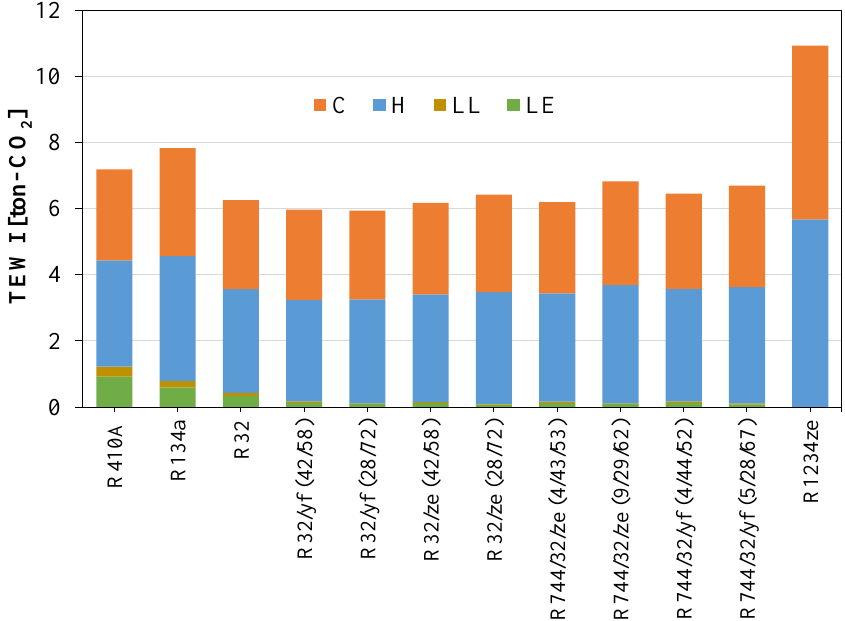
Figure 14. TEWI for different refrigerants considered for domestic applications. 4. Technical Difficulties and Remedies to Use Low-GWP Refrigerants ➢ Lack of thermophysical property data (experimental) for the mixtures to se- lect/study different binary or ternary mixtures. ➢ Most of the low-GWP refrigerant mixtures are non-azeotropic, so it has higher temperature glide, which avoids the pinch point formation in the condenser and evaporators during the two-phase flow. ➢ Irreversible loss as well as pressure drops in the condenser and evaporator increas- es due to the lower volumetric capacity of the mixture refrigerants [75].